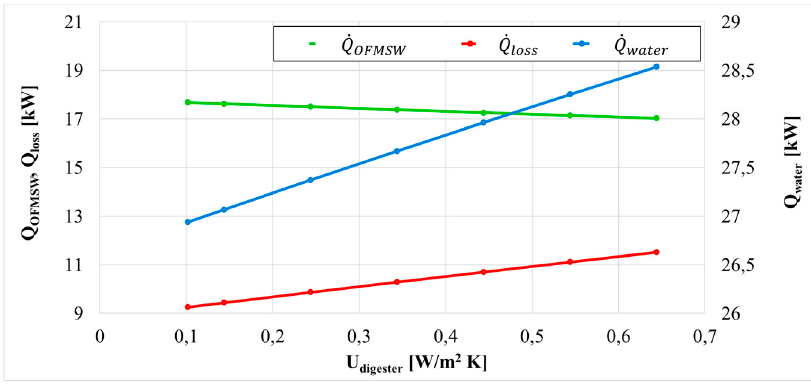
. . . . m & = 0.174 kg/s, m & = 0.557 Q & , Q & , Q & vs U Q OFMSW , Q loss , Q water vs. U digester for m OFMSW = 0.174 kg / s, digester for OFMSW water OFMSW loss water